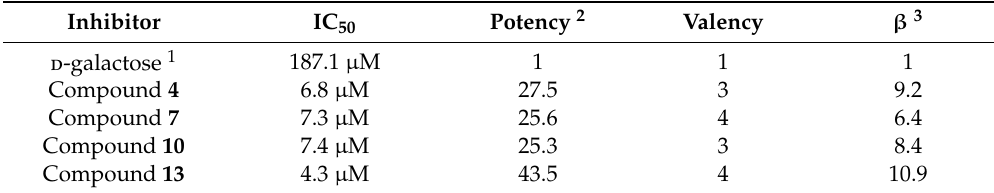
Table 2. The IC 50 (concentration of inhibitor resulting in 50% inhibition of binding) values and potencies of the tested inhibitors obtained by SPR for lectin PA-IL.